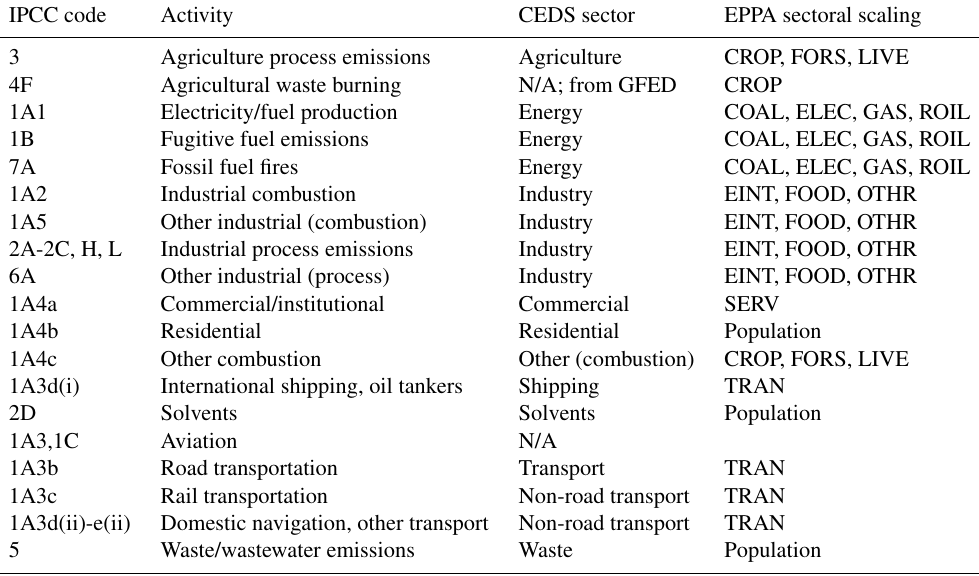
Table D1. IPCC sectoral definitions for EPPA scaling of sectors from the chosen emissions inventories. N/A sectors are not included in CEDS GBD-MAPS